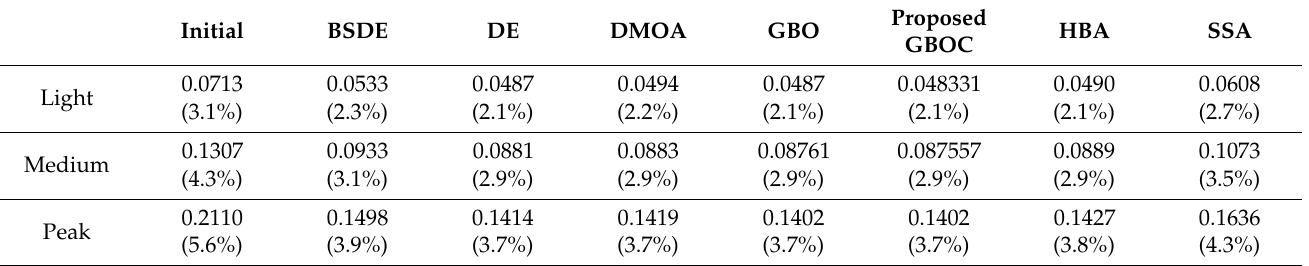
Table 3. Power losses (MW) and the percentage of each loading level are based on the obtained D-SVC devices in Table 2.